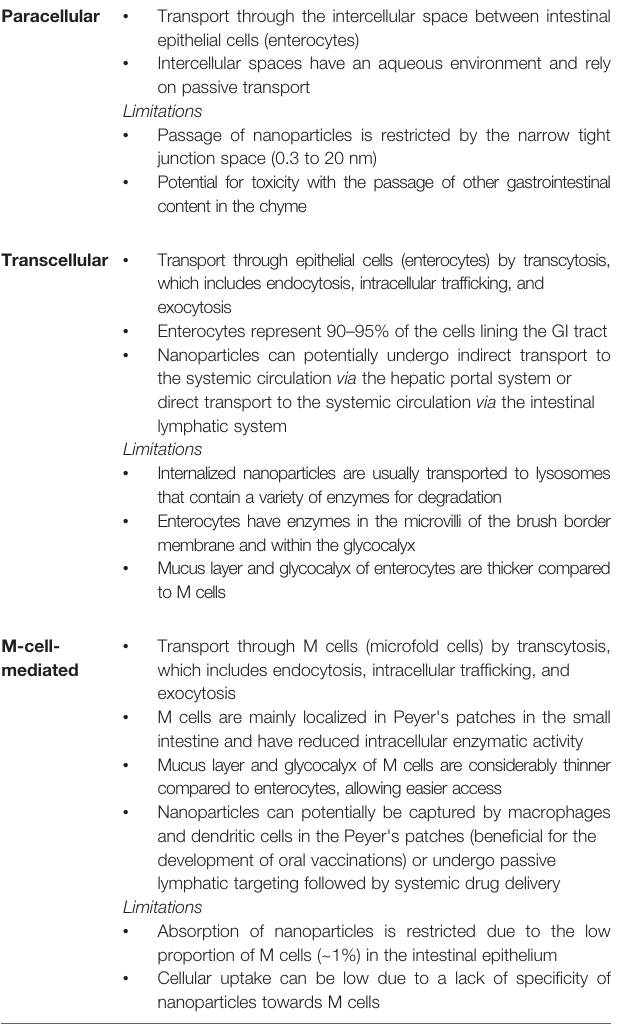
TABLE 3 | Summary of the main pathways that nanoparticles can take to cross the intestinal epithelium (Yu et al., 2016; Reinholz et al., 2018). Paracellular